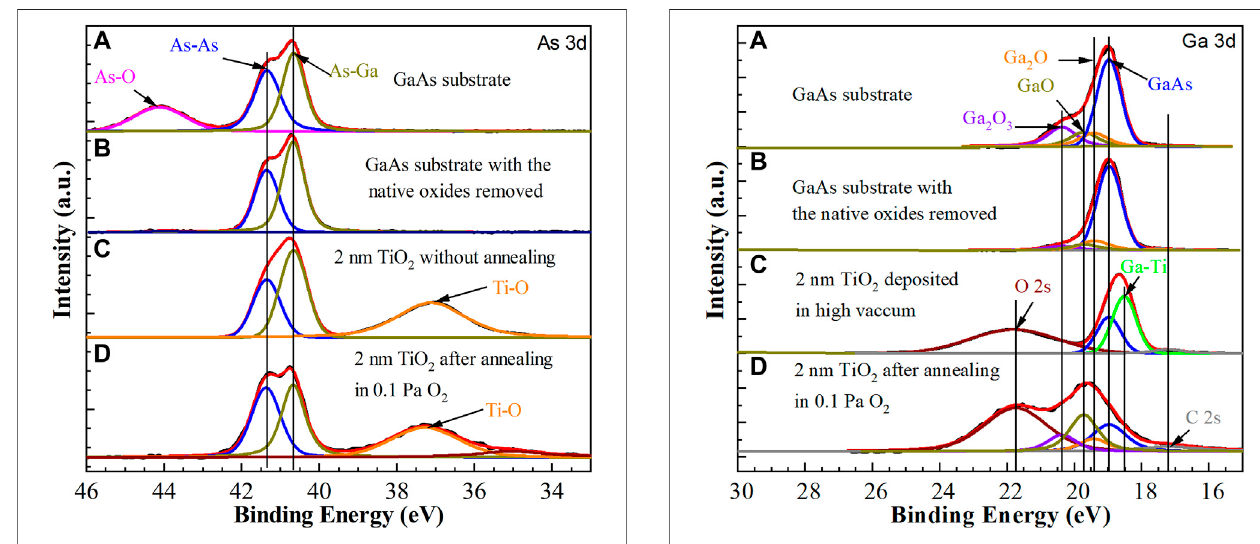
FIGURE 4 | (A) XPS core-level spectra of As 3d from (A) as-received GaAs wafer; (B) cleaned GaAs wafer without native oxides; (C) TiO 2 (2 nm)/ GaAs heterostructure without O 2 annealing; and (D) TiO 2 (2 nm)/GaAs heterostructure after O 2 annealing.